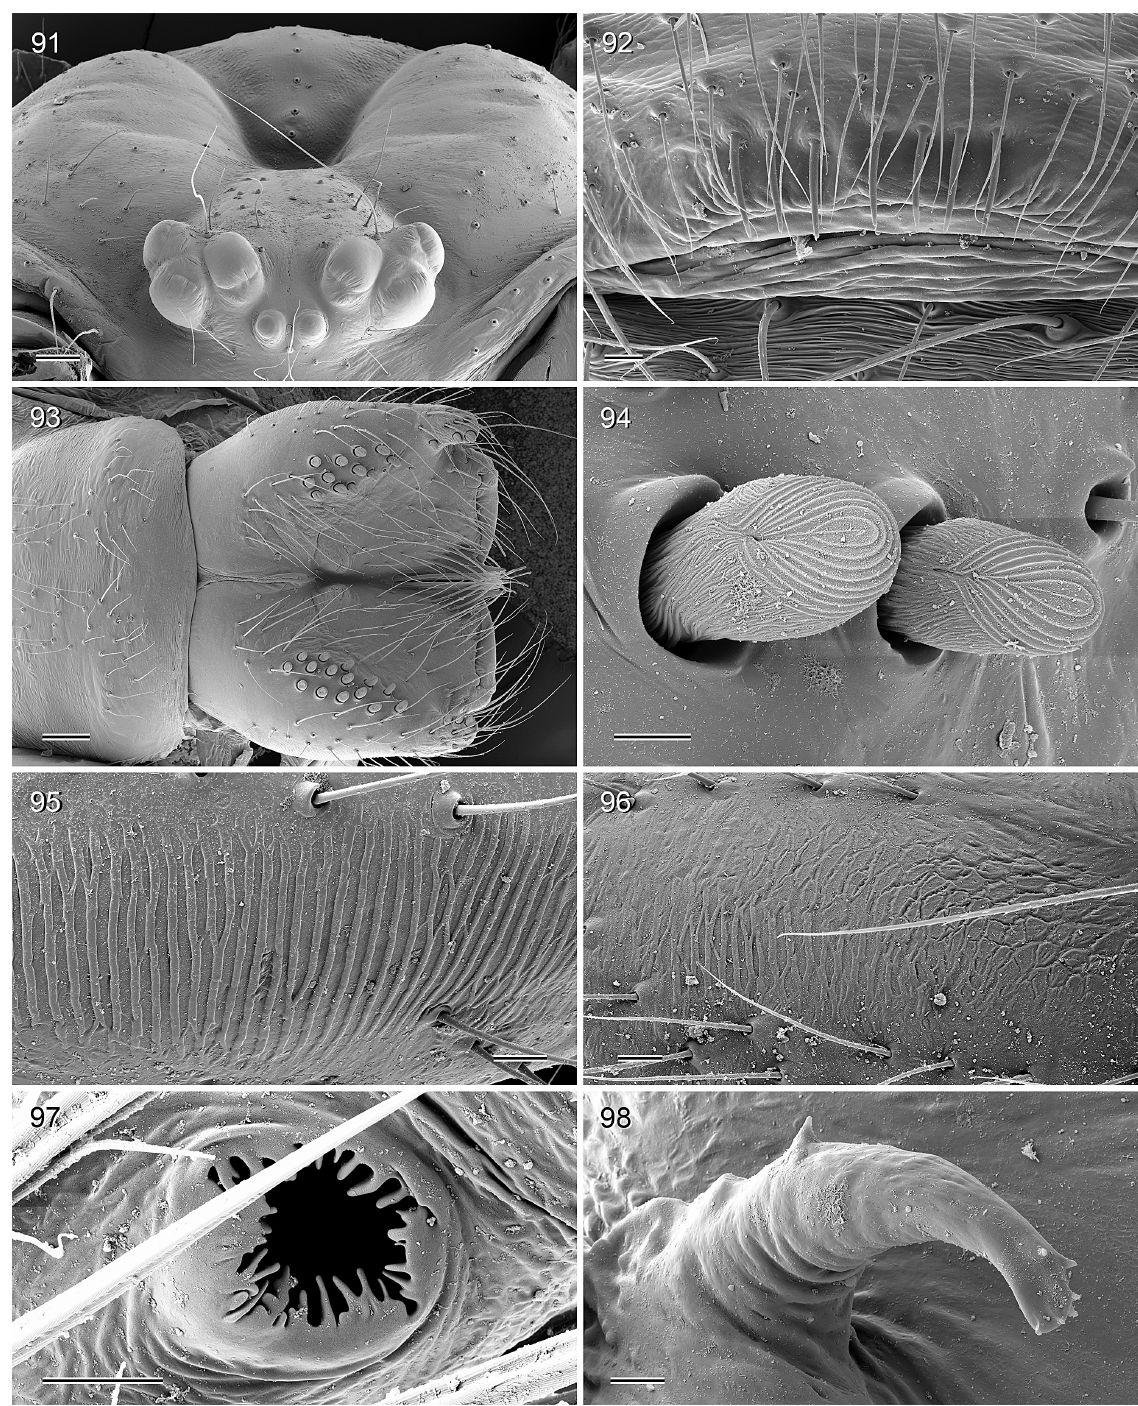
Figs 91–98. Stygopholcus montenegrinus Kratochvíl, 1940; male and female from Studenačka pećina, Montenegro (ZFMK (Ar 22201)). 91 . Male carapace and ocular area, frontal-dorsal view. 92 . Male gonopore and epiandrous spigots. 93 . Male clypeus and chelicerae, frontal view. 94 . Modified hairs frontally on male chelicerae. 95–96 . Stridulatory files on male and female chelicerae. 97 . Tarsal organ on male tarsus 1. 98 . Transparent process on genital bulb. Scale bars: 91, 93 = 100 µm; 92, 95–96 = 20 µm; 94, 97–98 = 10